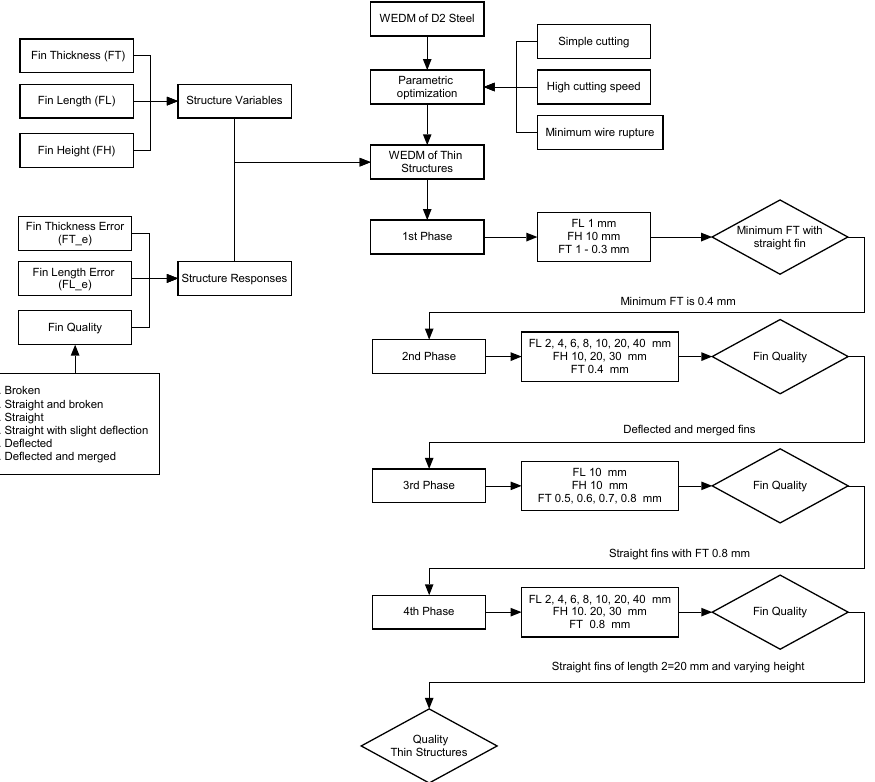
Figure 2. Research methodology to fabricate high aspect ratio thin structures in D2 steel through wire electric discharge machining (WEDM).